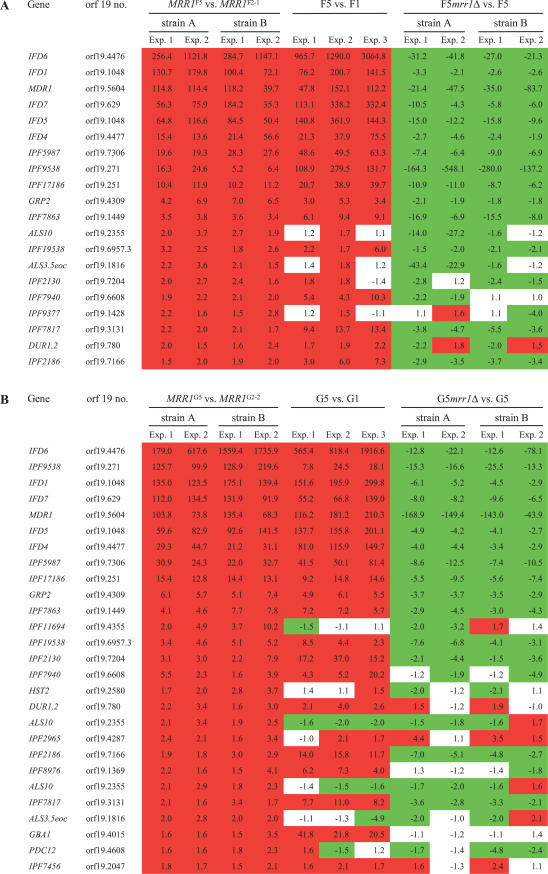
Identification of Mrr1p Target Genes by DNA Microarray Analysis(A) Genes that were upregulated by the P683S mutation in the SC5314 genetic background (MRR1
F5 versus MRR1
F2–1). The genes are ordered according to their average degree of upregulation in four repeat experiments performed with two independent transformants (strains A and B). The changes in the expression level of these genes in the drug-resistant clinical isolate F5 as compared with a matched susceptible isolate (F5 versus F1) and in two independently constructed mrr1Δ mutants (strains A and B) as compared with their wild-type progenitor F5 (F5mrr1Δ versus F5) are shown for comparison.(B) Genes that were upregulated by the G997V mutation in the SC5314 genetic background (MRR1
G5 versus MRR1
G2–2). The genes are ordered according to their average degree of upregulation in four repeat experiments performed with two independent transformants (strains A and B). The changes in the expression level of these genes in the drug-resistant clinical isolate G5 as compared with a matched susceptible isolate (G5 versus G1) and in two independently constructed mrr1Δ mutants (strains A and B) as compared with their wild-type progenitor G5 (mrr1Δ versus G5) are shown for comparison.The fold increase or decrease in the expression of the genes is given for each experiment. Upregulated genes are highlighted in red, downregulated genes are highlighted in green, and genes that were not differentially expressed are shown as white boxes in all pairwise comparisons.